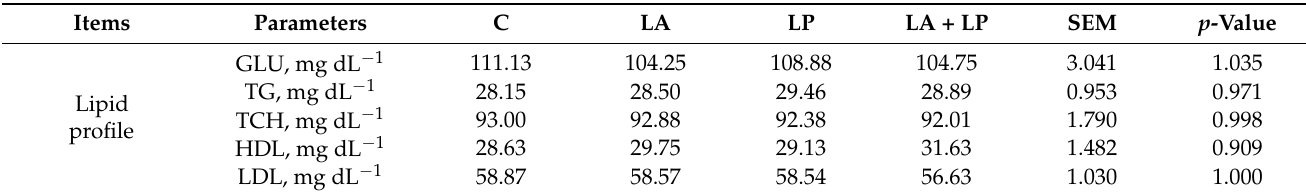
Table 4. Effects of microencapsulated probiotics supplements on plasma parameters of post- weaning